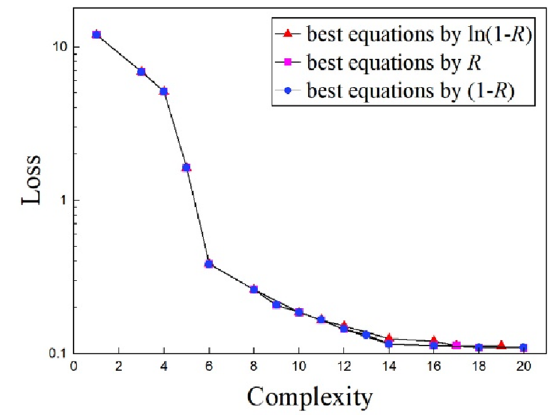
Figure 5 Pareto front of best equations showing Complexity and